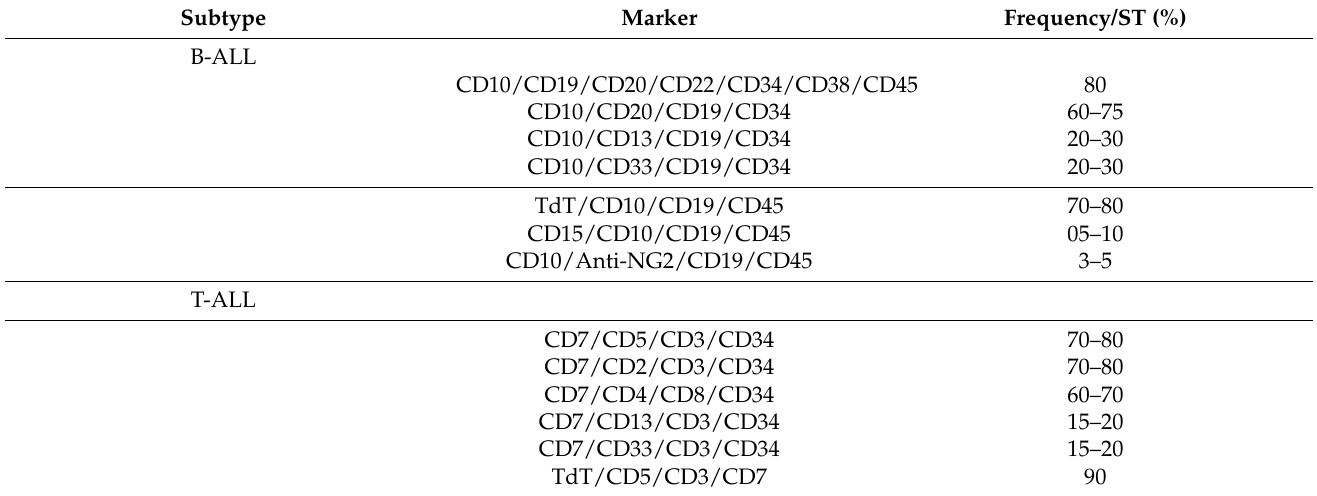
Table 2. Commonest antigens combinations for monitoring MDR by flow